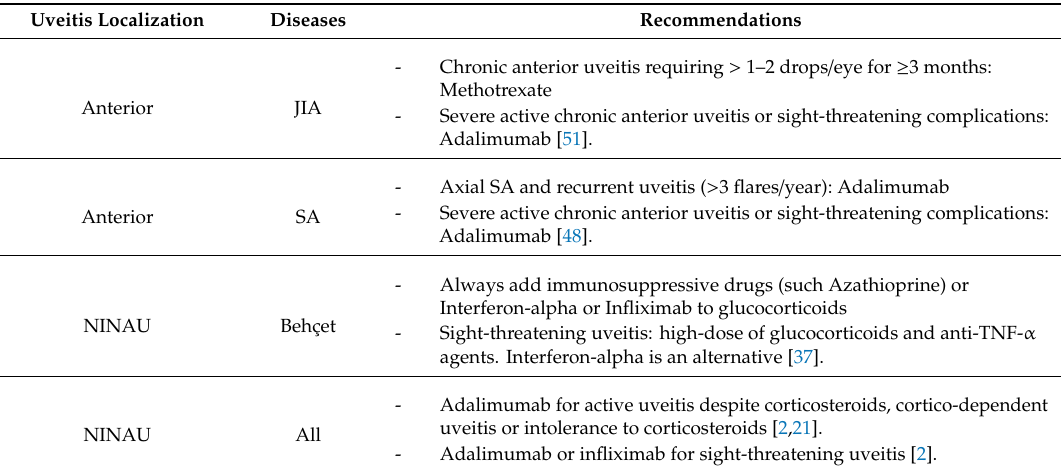
Table 2. Summary of the various recommendations of international experts systemic therapy and anti-TNF- α use in non-infectious uveitis